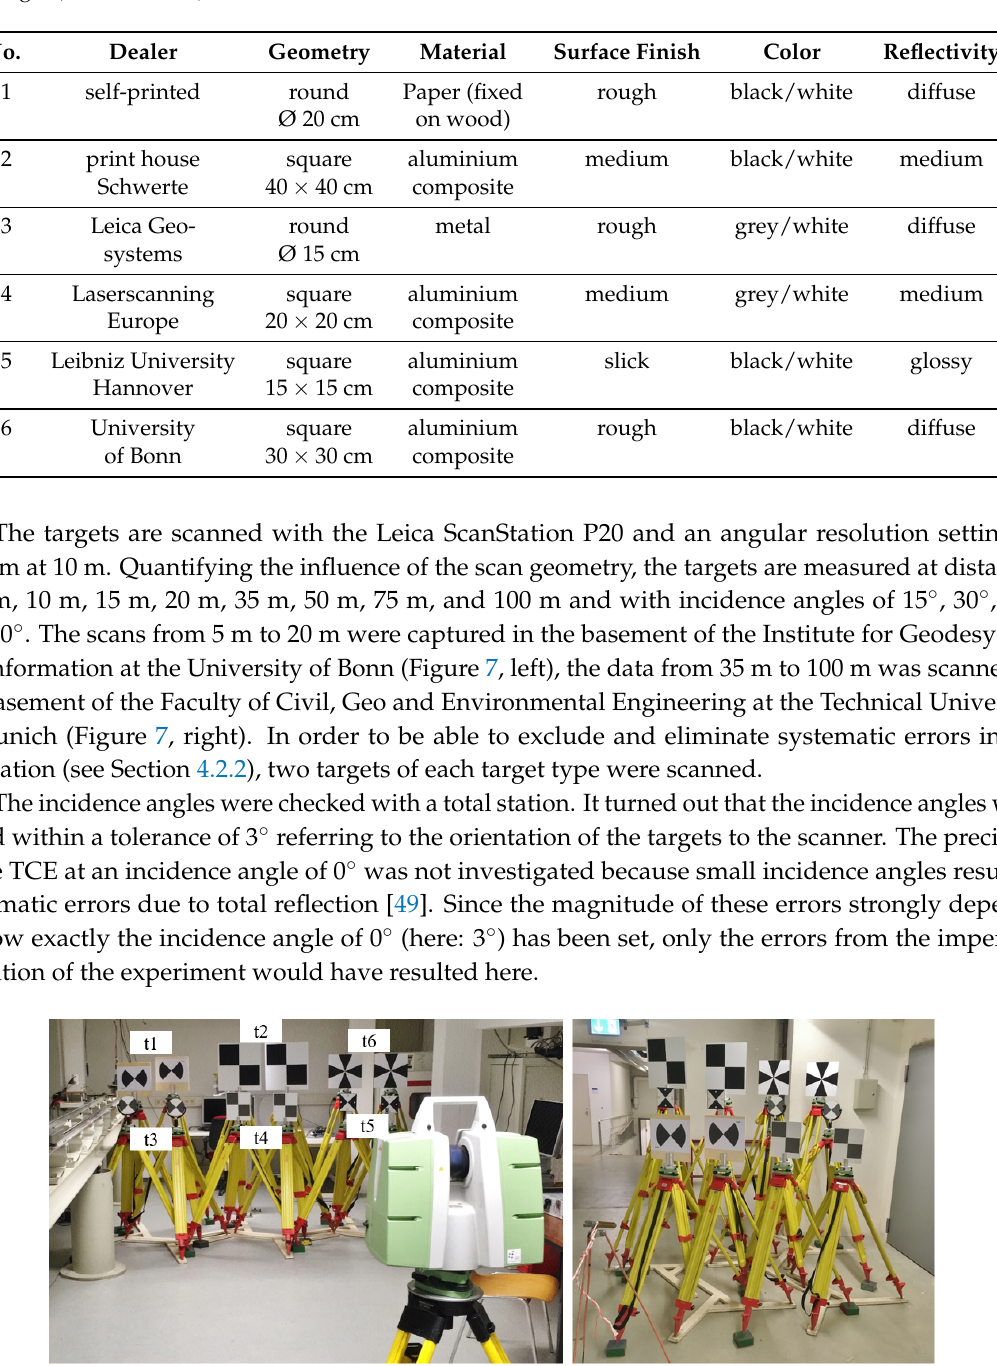
Table 3. Characteristics of the five tested target designs (t1–t5, Section 4.2) and of the newly developed target (t6, Section 4.3).